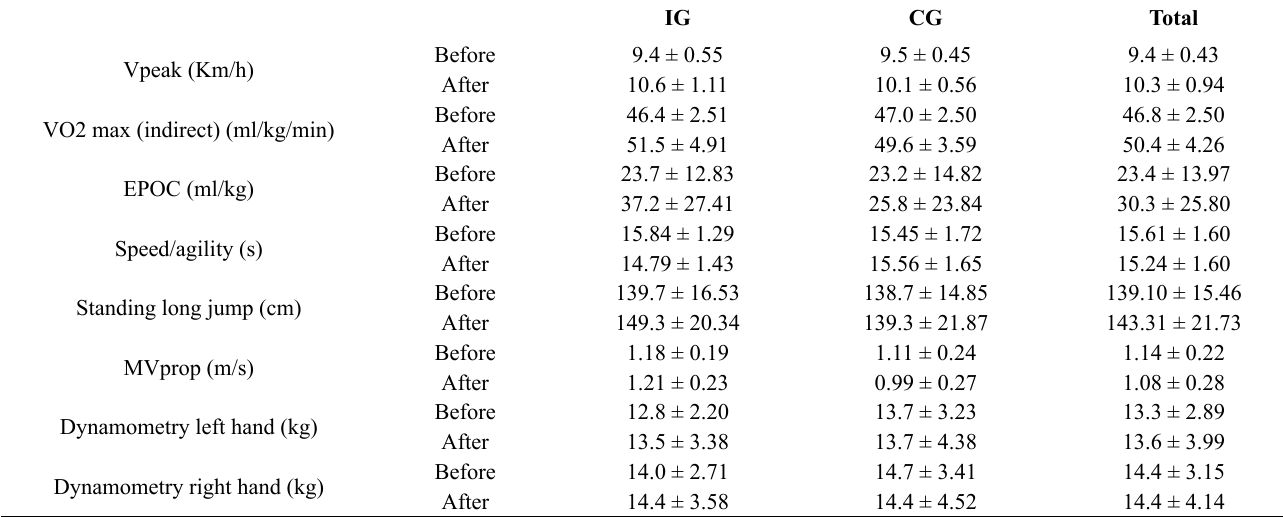
Table 2. Health-related fitness variables (M ± SD) recorded before and after a 12 week extracurricular, moderate-intensity training (MIT) or high- intensity interval training (HIIT) program.